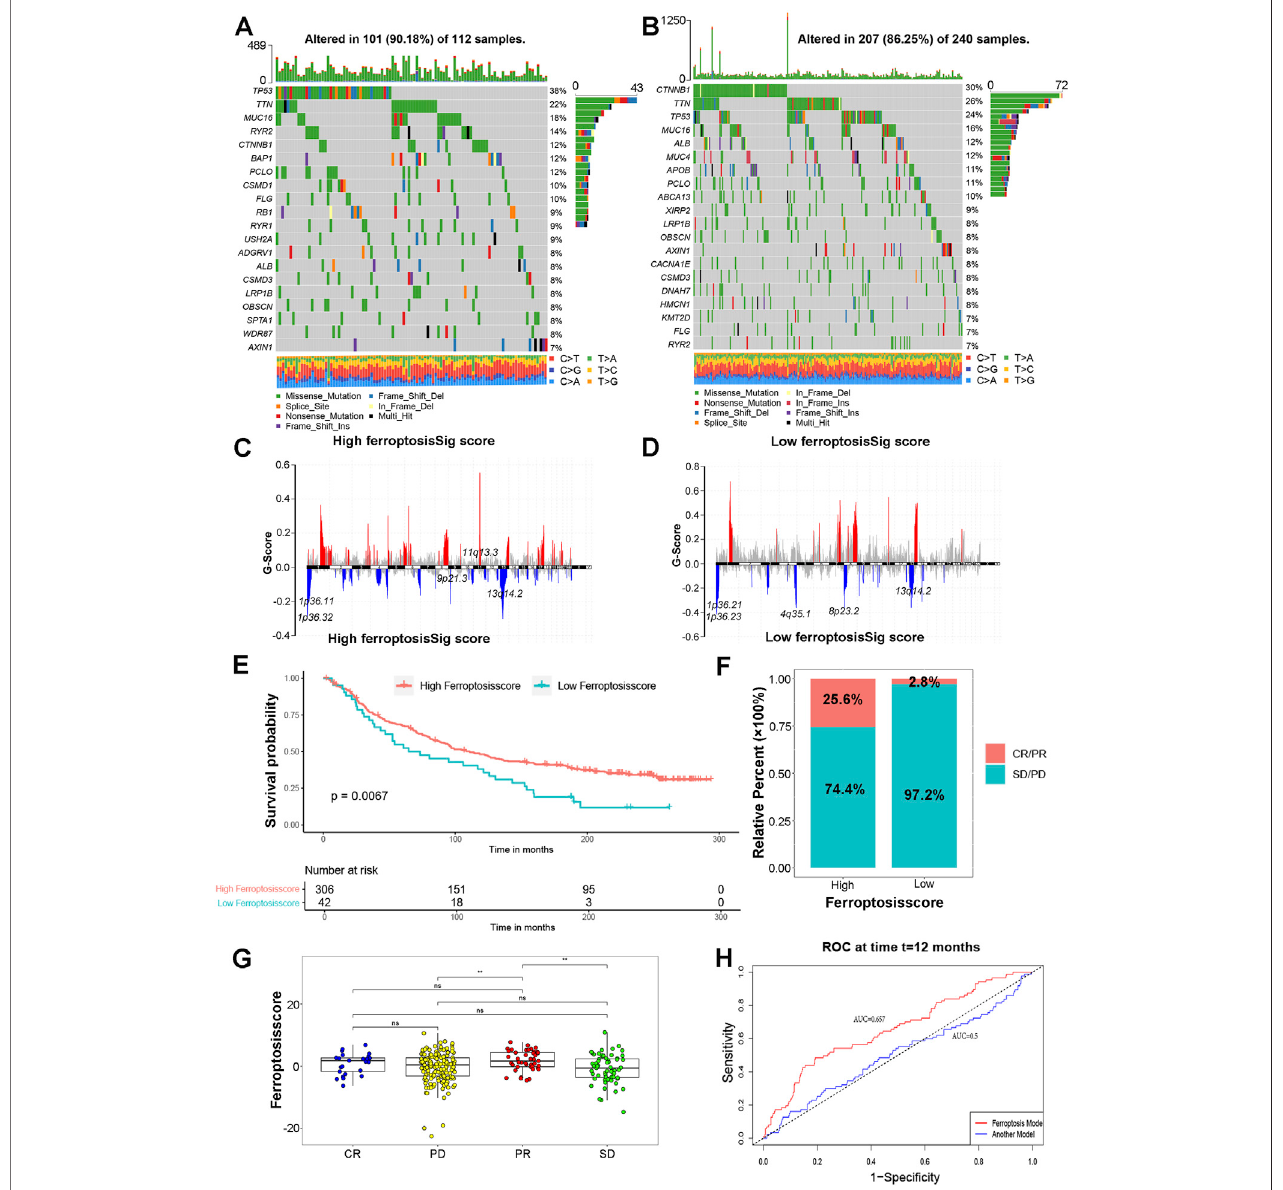
FIGURE6| TheroleofferroptosisSigscoreinpredicting immunotherapeutic bene fi ts. (A,B) Thewaterfallplotoftumor somaticmutationestablished bythosewith (A) highferrptosisSig scoreand (B) lowferroptosisSigscore. (C,D) CNVmutationG-scoreof (C) highferrptosisSigscoreand (D) lowferroptosisSigscoresubgroup. (E) Kaplan-Meier curves for patients with high and low ferroptosisSig score subgroups in HCC patients. Log-rank test, p = 0.0067. (F) The proportion of patients with responsetoPD-1blockadeimmunotherapyinloworhighferroptosisSigscoregroups. (G) DifferencesinferroptosisSigscoreamongdistinctcheckpointblockade therapy response groups. The asterisks represented the statistical p value (* p < 0.05; ** p < 0.01; *** p < 0.001). (H) The predictive value of the quanti fi cation of ferroptosisSig score in patients treated with anti-PD-1/L1 immunotherapy (AUC = 0.657).